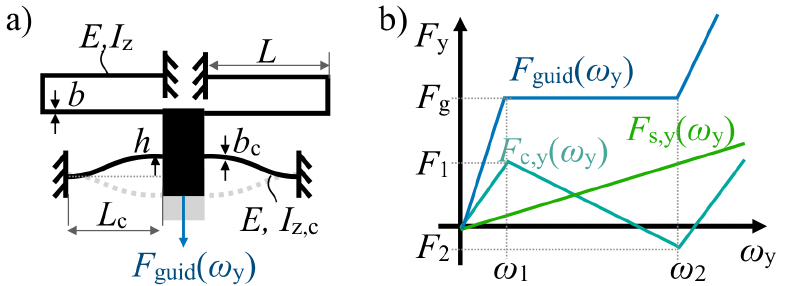
Figure 2. ( a ) Schematic of the combined spring system featuring a linear serpentine spring and a curved cosine-shaped buckling beam. ( b ) The individual and combined force-displacement charac- teristics of the serpentine and the curved